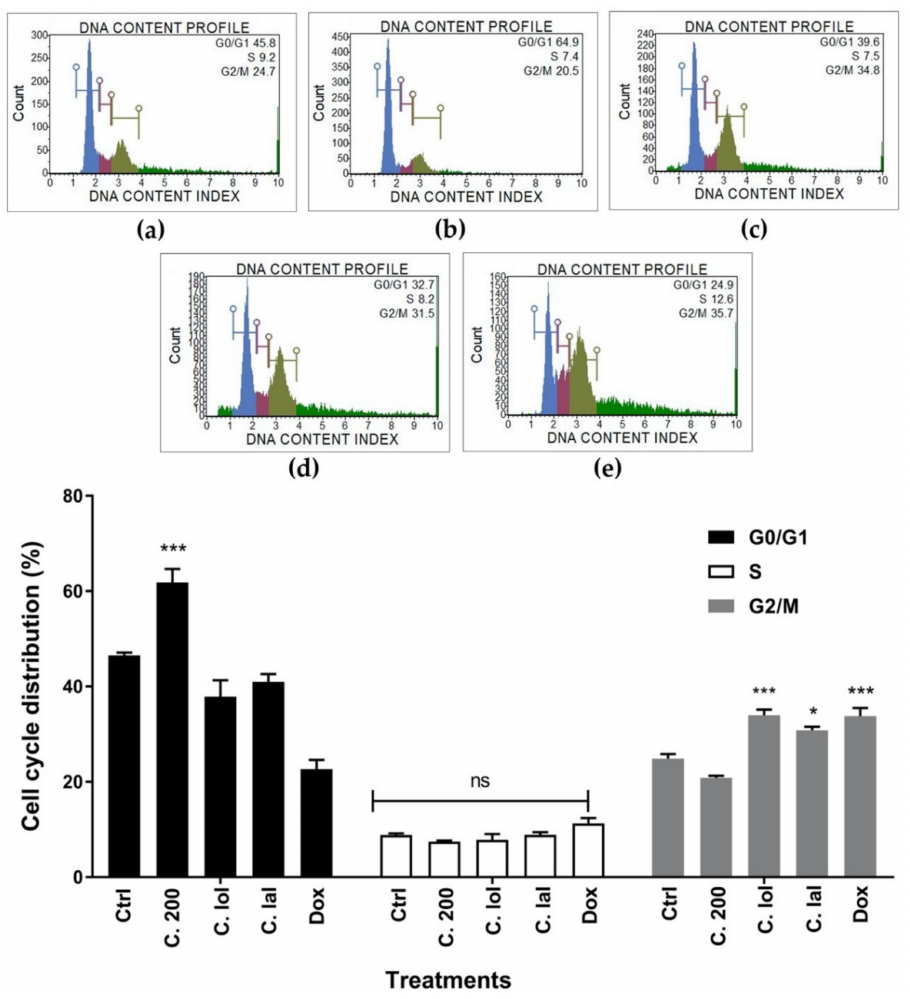
Figure 5. Cell cycle arrest induced by treatment groups on MDA-MB-231 cells. ( a ) Control (Ctrl), ( b ) crude hexane extract 200 µ g / mL (C.200), ( c ) citronellol 1 nM (C. lol), ( d ) citronellal 1 nM (C. lal), ( e ) Doxorubicin 0.5 µ M (Dox). Data are presented as means ± SEM. One-way ANOVA with